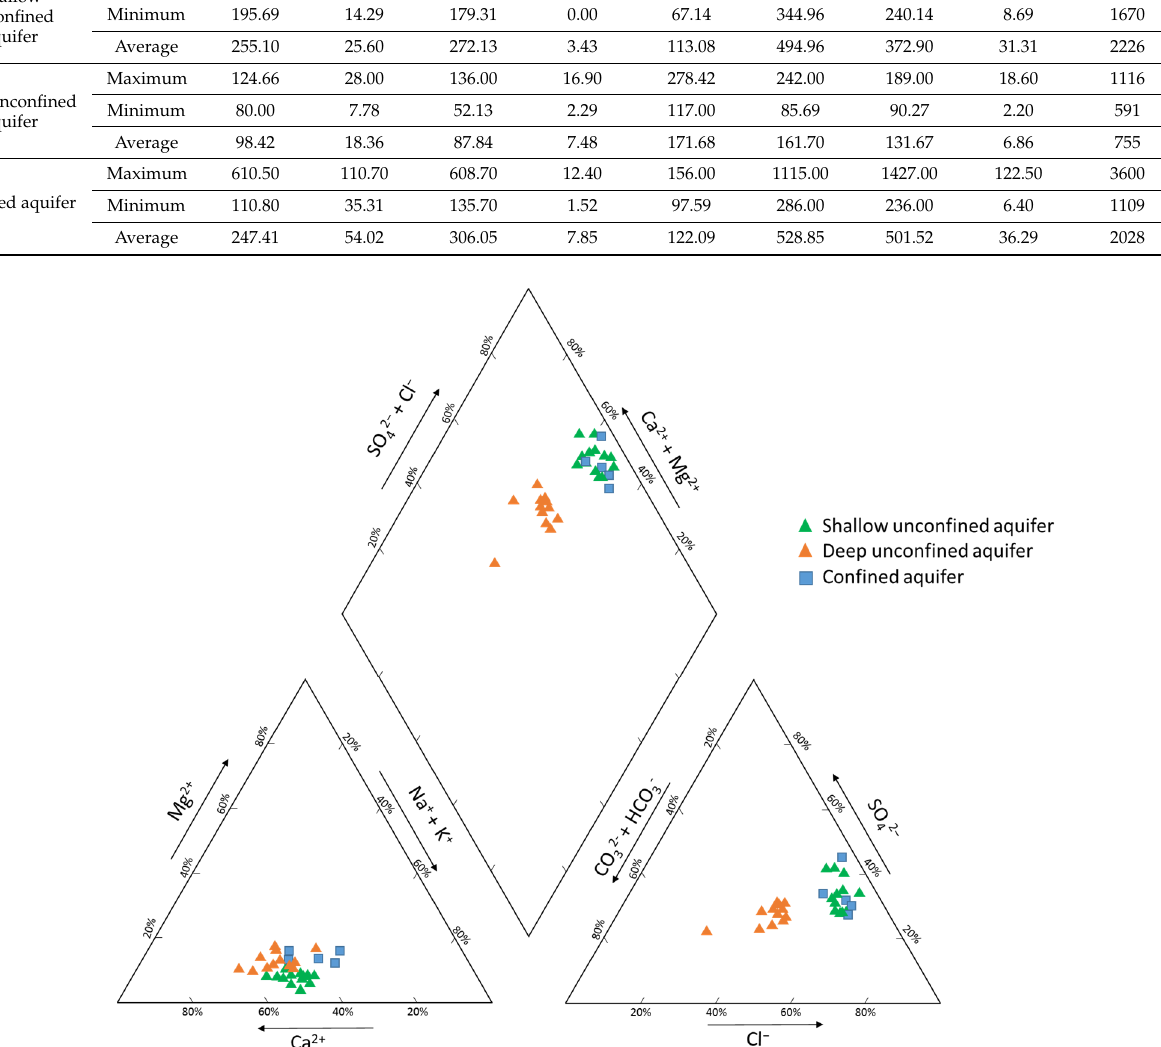
Figure 5. Piper plot for groundwater samples from shallow, deep unconfined, and deep confined Wajid aquifers in Wadi Al-Dawasir.